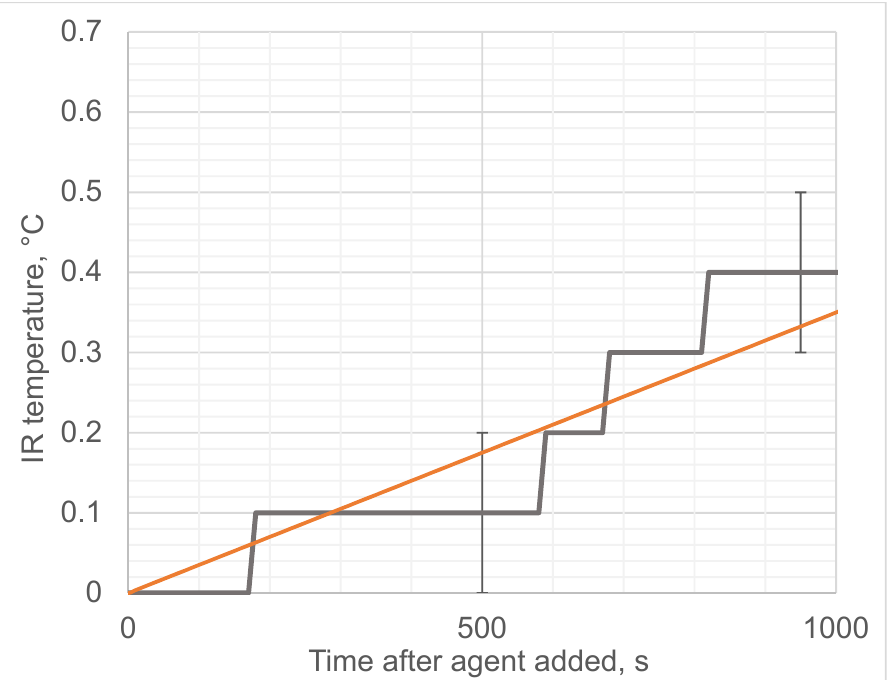
Figure 8. Microwave emissions (brightness temperature) when adding ethanol to tap water during control experiment with no egg white. Black solid line denotes experimental observations. Orange line denotes approximation (slope).